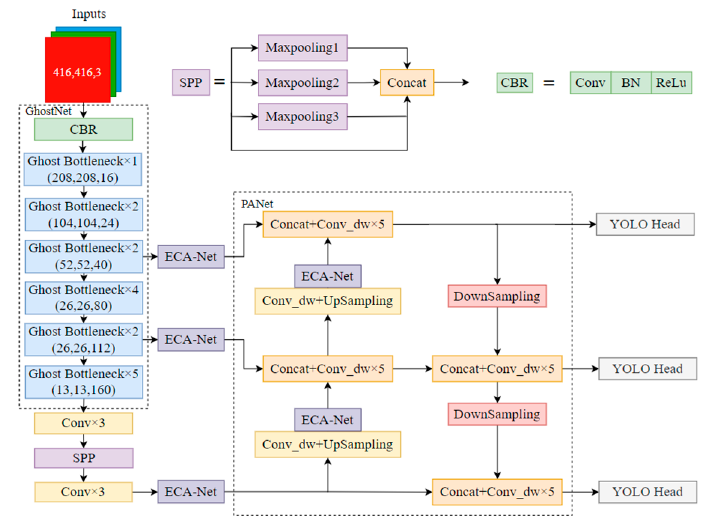
Figure 8. Improved YOLOv4 network structure.